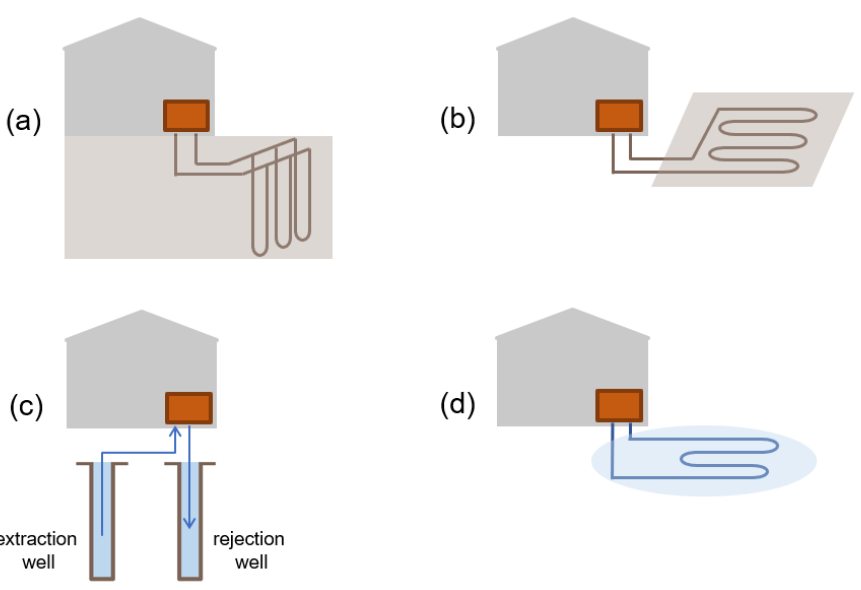
Figure 5. GSHP main typologies: ( a ) ground coupled heat pump with vertical GHE; ( b ) ground coupled heat pump with horizontal GHE; ( c ) ground water heat pump; ( d ) surface water heat pump.